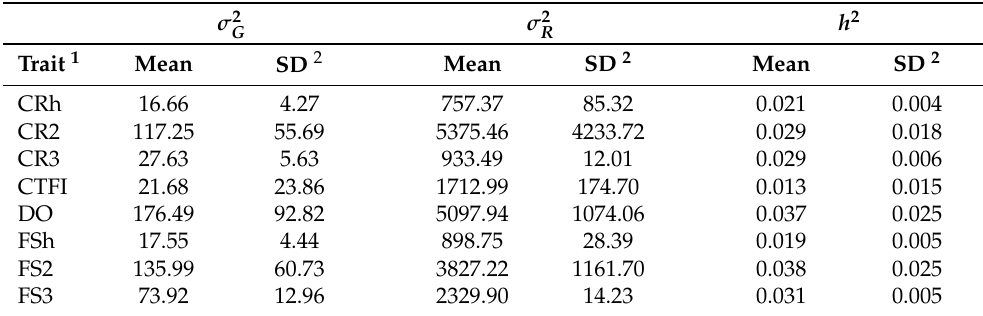
Table 3. Estimated genetic ( σ 2 female